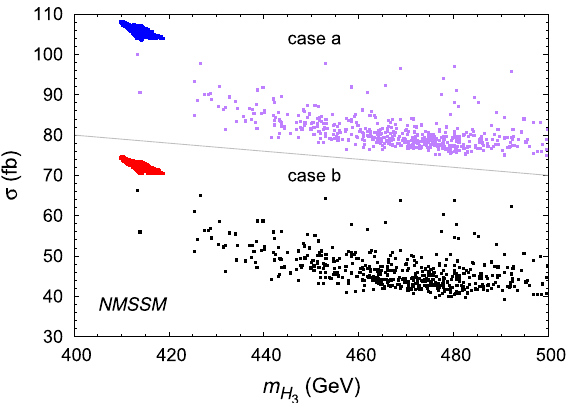
Fig. 3 Left – Cross sections corresponding to the cases a (top half) and b (bottom half) for the scanned NMSSM points, with those shown in blue and red in the respective halves being the ones with < 5GeV. Right – The ratio of the cross sections b and c as a (cid:11) m H